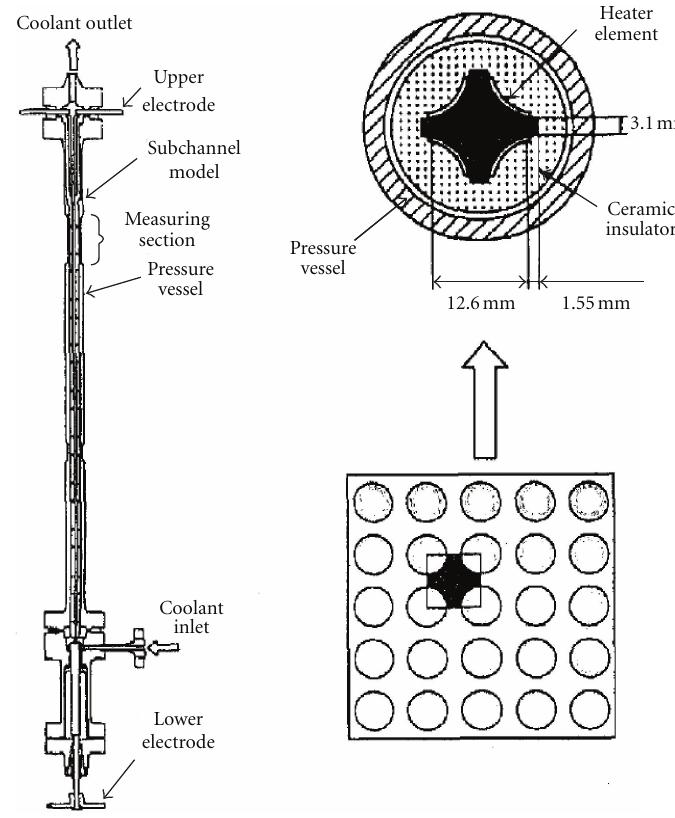
Figure 1: Test section for void measurement in a central subchannel. Table 1: Distribution of deviations: “calculated minus measured void fraction” in the di ff erent series of single subchannel PSBT tests. Test number Average Standard